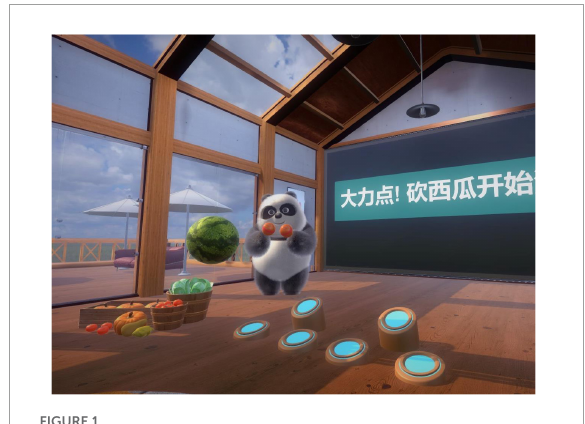
FIGURE1 Users’ field of vision from virtual reality (VR)